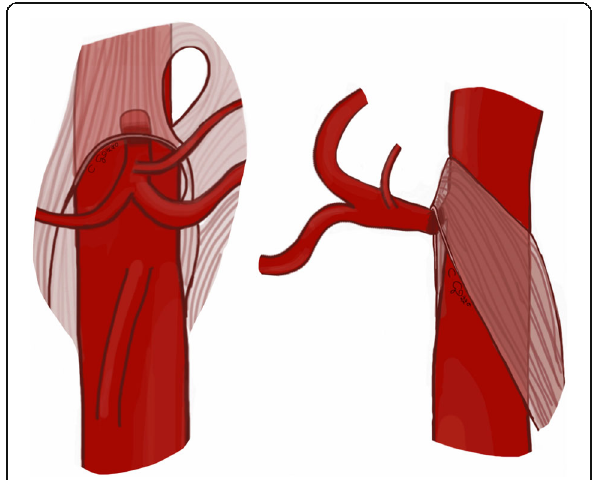
Fig. 1 Drawing illustrating the coronal and sagittal views of the median arcuate ligament compressing the root of the celiac